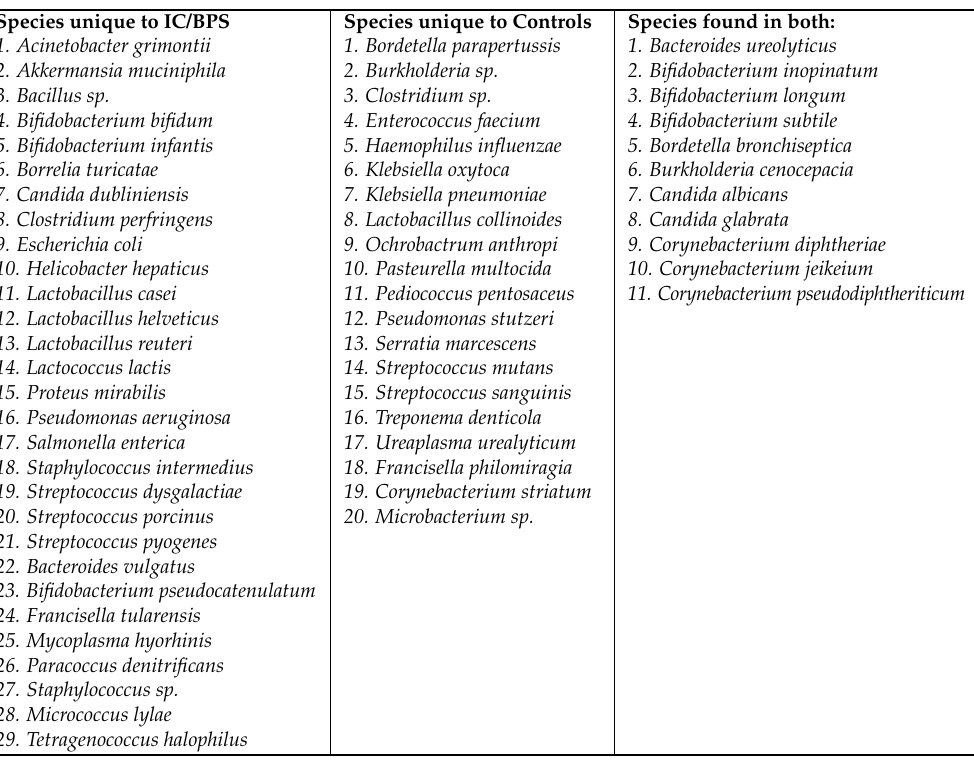
Table 3. Unique and overlapping species identified in IC/BPS and control subjects.